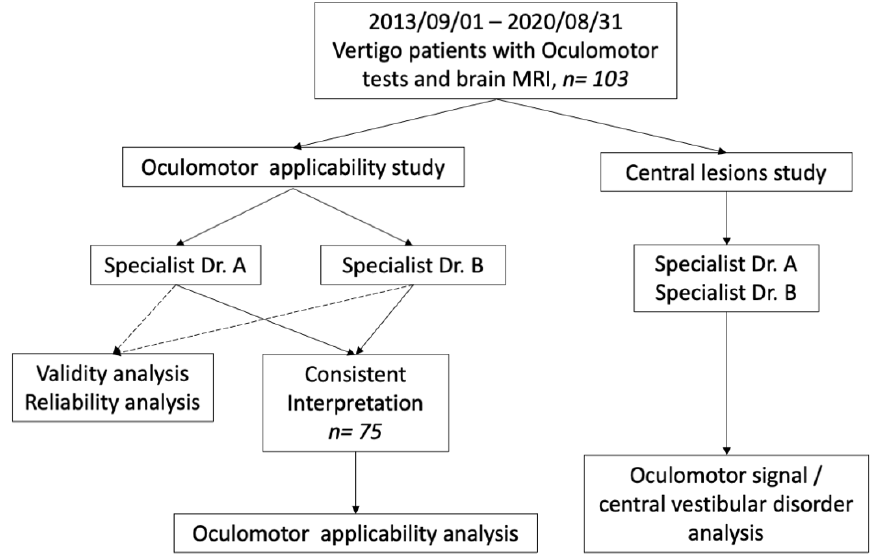
Figure 1. Flow diagram of the overall study design.